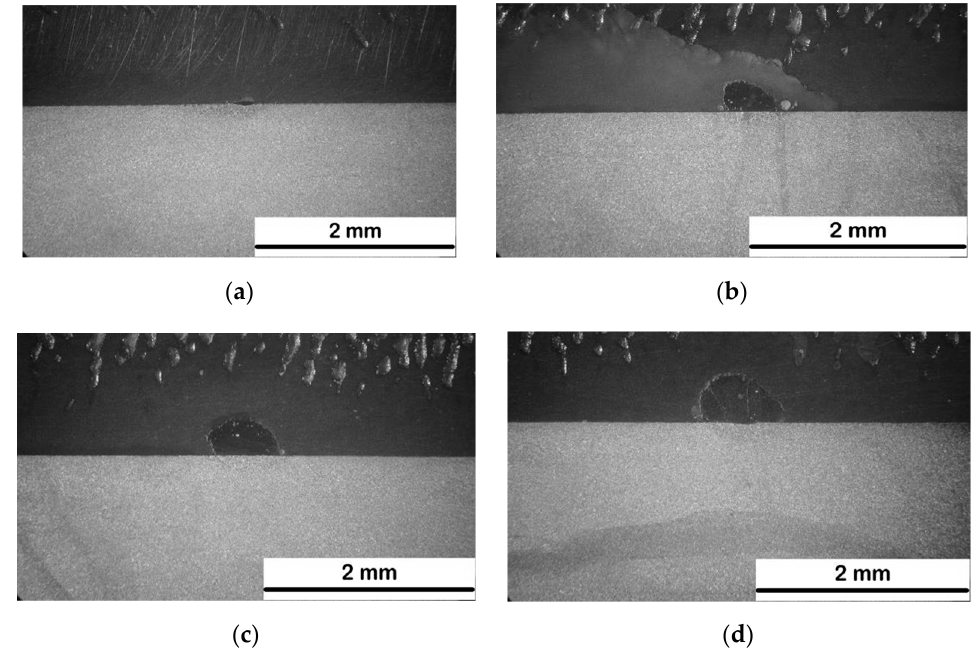
Figure 8. Macrostructure and the single bead geometry of the clad layers produced by laser deposition of Fe-based powder on steel substrate at forced cooling by liquid nitrogen bath under cryogenic conditions (hybrid laser deposition process), constant scanning speed 500 mm/min, and different laser output power, as shown in Tables 3 and 4: ( a ) HC5, 250 W; ( b ) HC6, 500 W; ( c ) HC7, 750 W; ( d ) HC8, 1000 W.